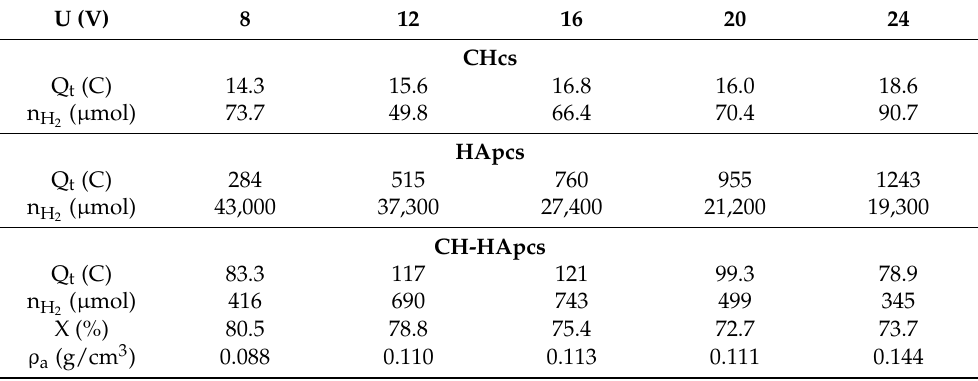
Table 2. Quantitative characteristics of electrodeposition from chitosan, hydroxyapatite, and chitosan- hydroxyapatite colloidal solutions. Data are shown as mean values (n = 3). Q t —total electric